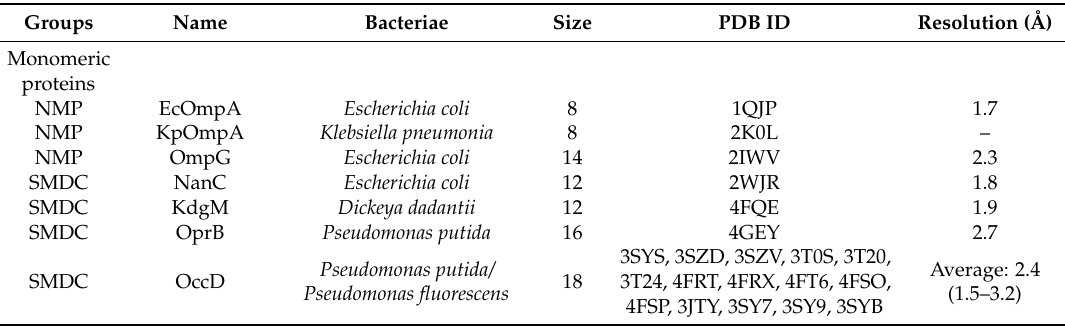
Table 1. Protein structure information of bacterial porins and specific diffusion channels. This table lists protein names and biological and structural information of the structures used in our analyses. The size column lists the number of β